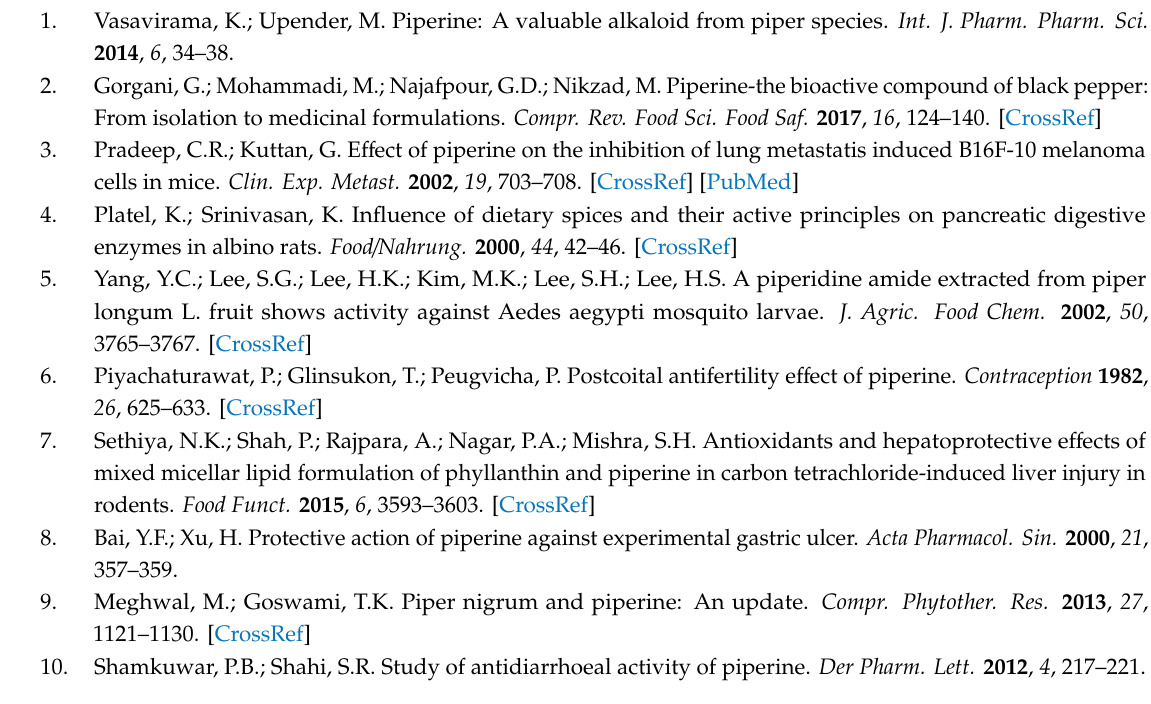
Supplementary Materials: The following are available online, Figure S1: Correlation of experimental solubility values of PPN with “Van’t Ho ff model” in di ff erent “THP + water” mixtures at “ T = 298.2–318.2 K”; Van’t Ho ff model solubility values of PPN are represented by solid lines, and experimental solubility values of PPN are represented by the symbols, Table S1: Hansen solubility parameters ( δ mix / MPa 1 / 2 ) for various THP + water mixtures free of PPN at “ T = 298.2 K”, Table S2: The values of mixing enthalpy ( ∆ mix H / J mol − 1 ), mixing entropy ( ∆ mix S / J mol − 1 K − 1 ), mixing Gibbs energy ( ∆ mix G / J mol − 1 ) and activity coe ffi cient ( γ i ) for PPN dissolution in di ff erent “THP + water”